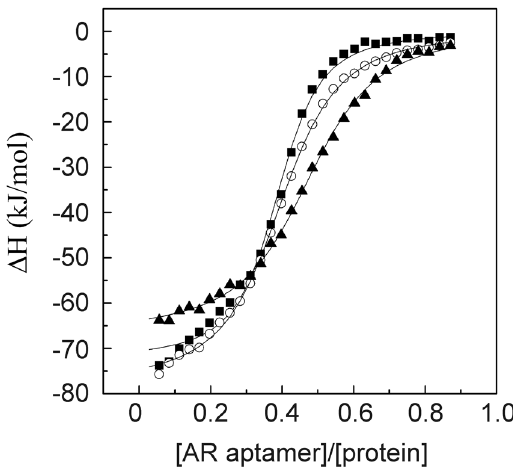
Figure 8. Determination of the AR aptamer/arginine-rich peptide complex dissociation constants. Integrated heats of binding corrected for heats of dilution from titrations of R 8 -GST (squares), R 6 -GST (circles) and Tat 49–57 -GST (triangles) into the solution of AR aptamer at 25 °C. Experiments were performed in 50 mM phosphate buffer (pH 7.6) containing 207 mM NaCl. Solid lines represent the best-fit binding isotherms to the experimental data.